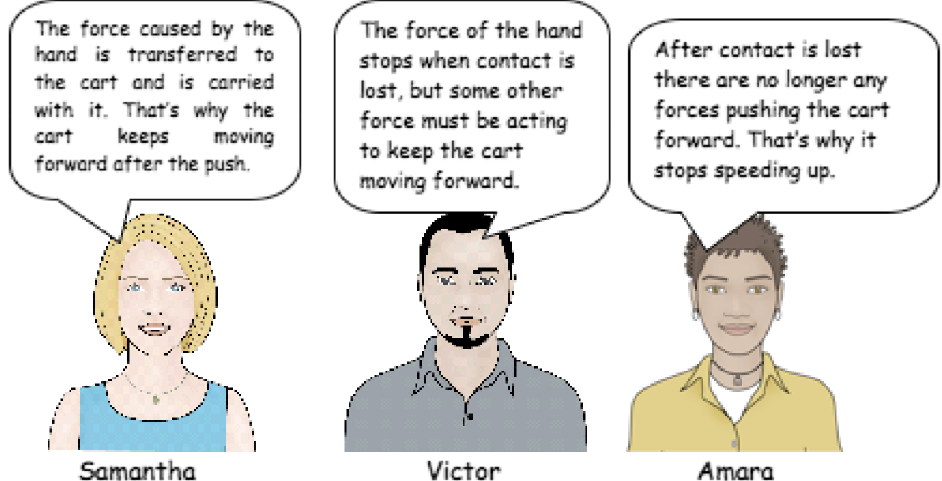
FIG. 8 (color online). Discussion between three fictional students about the relation between motion and force after the hand stops pushing the cart.